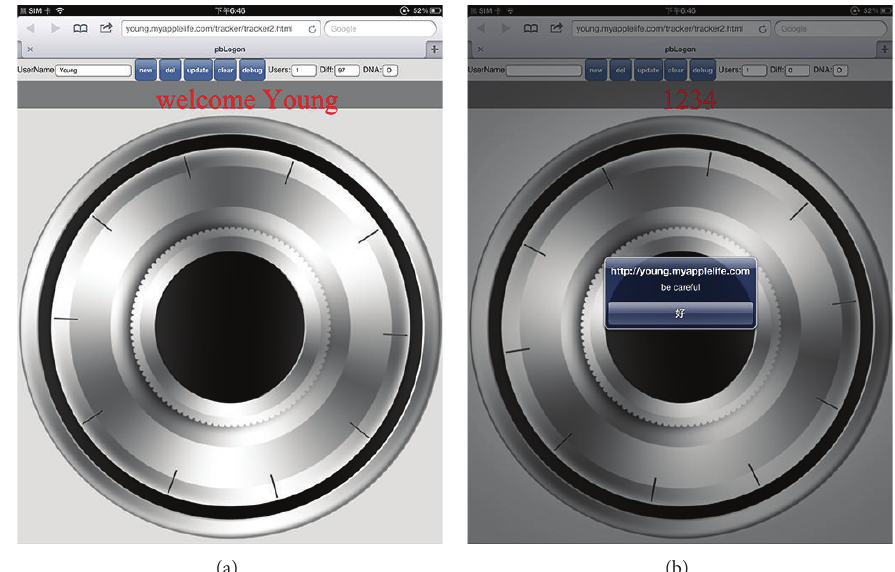
Figure 8: Example of pbAuth. (a) Presents the user logon successfully with a welcome message. (b) Presents the user does not make it due to the threshold we made.